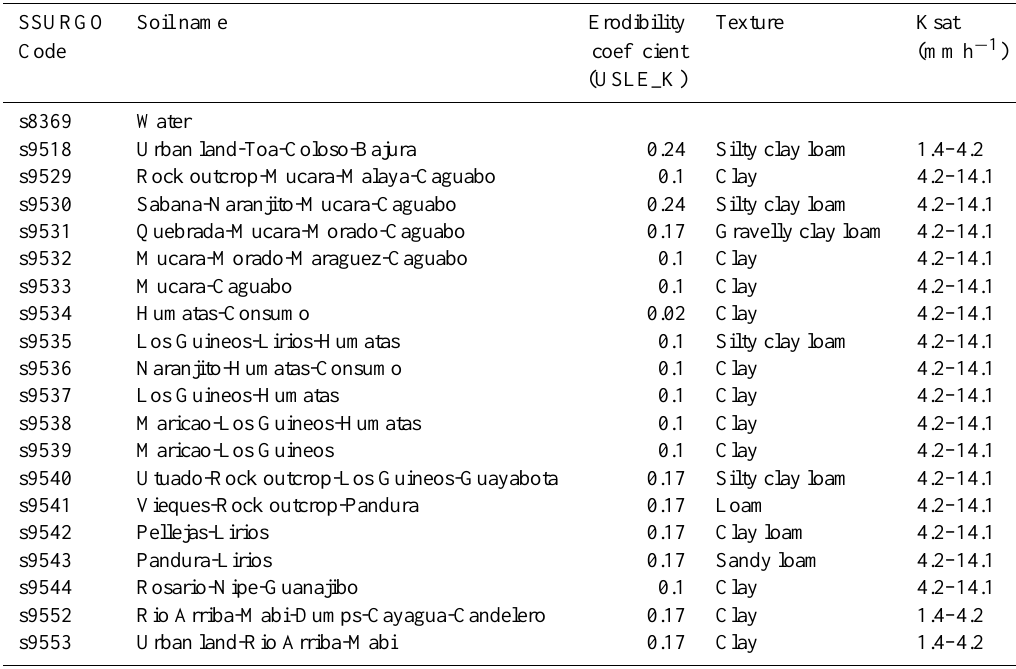
Table 4. Soil types and their erodibility, texture, and hydraulic conductivity. SSURGO